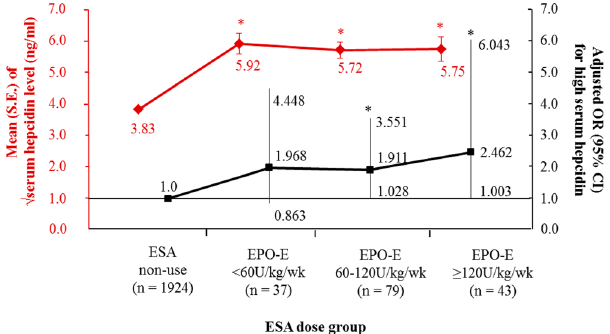
Figure 1. Dose relationship between erythropoietin stimulating agents (ESA) usage and serum hepcidin level. S.E., standard error; EPO-E, epoetin-equivalent. * Meant P < 0.05 when compared to ESA non-use group. Adjusted odds ratio (OR) and it confidence interval (CI) for high serum hepcidin were calculated by using multivariable logistic regression entering age, sex, ever smoking, hypertension, diabetes, stage of chronic kidney disease, hemoglobin, transferrin saturation, iron supplements, white blood cells, C-reactive protein, urine protein-to-creatinine ratio, albumin, cholesterol and bilirubin as covariates.